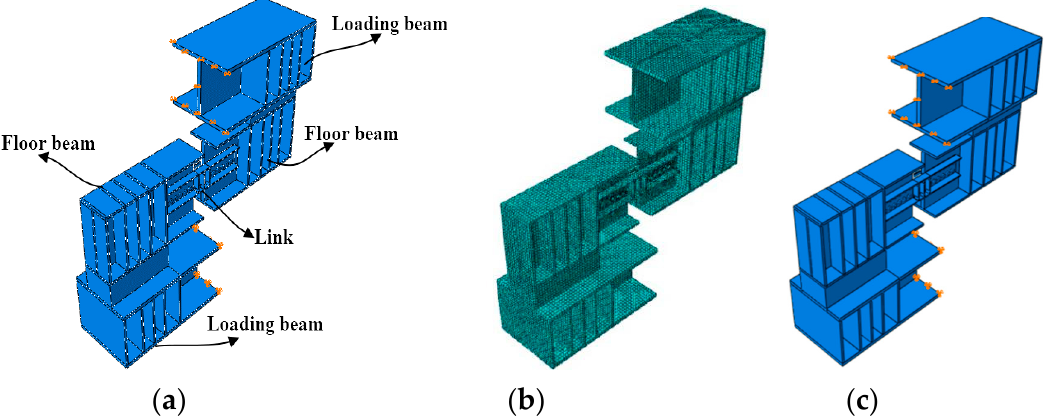
Figure 15. Finite element model ( a ); Mesh division diagram ( b ); and, Finite element model constraint diagram ( c ).